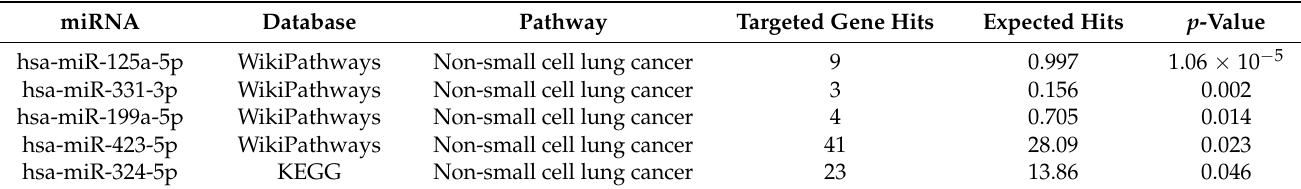
Table 3. Enrichment analysis of DEM-targeted genes by